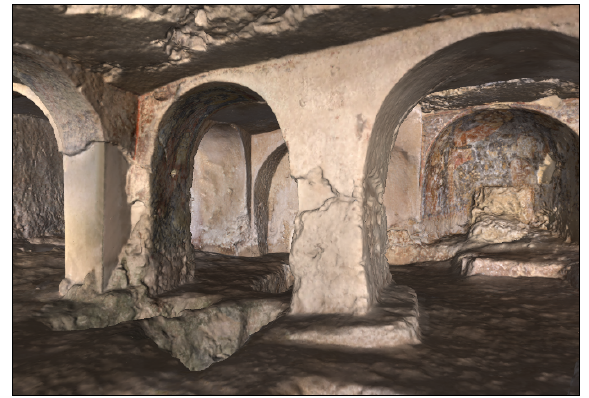
Figure 6. 3D model with mapped colour for the fruition of the church